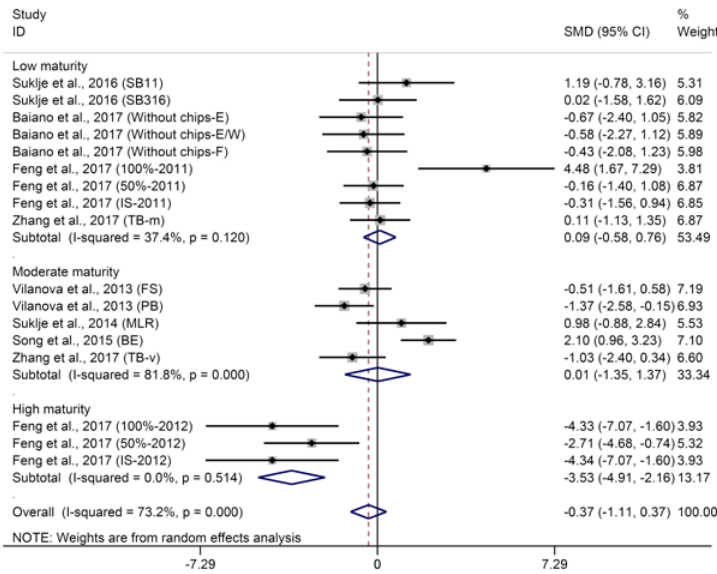
Figure 4. Meta-analysis for the effects of basal defoliation on 1-hexanol in wine, of which trials were categorized based on the berry maturity level (low maturity of °Brix < 23, moderate maturity of 23 < °Brix < 25, high maturity of °Brix > 25).